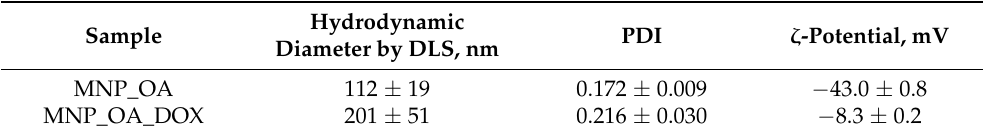
Table 3. Hydrodynamic diameter, polydispersity index (PDI), and ζ -potential of synthesized MNP_OA_DOX in water.